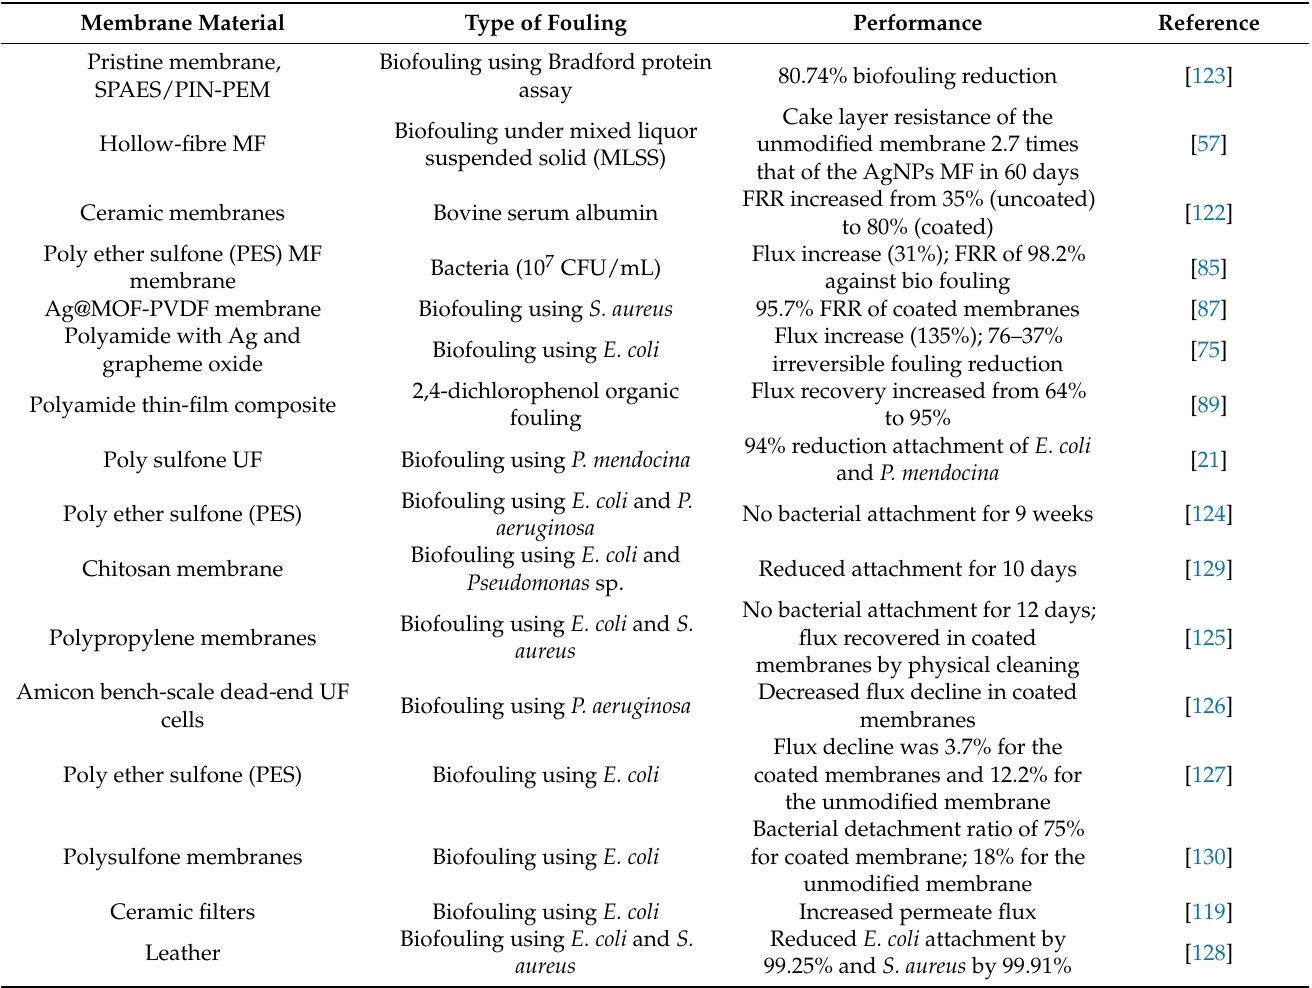
Table 4. Antifouling performance of AgNP-coated